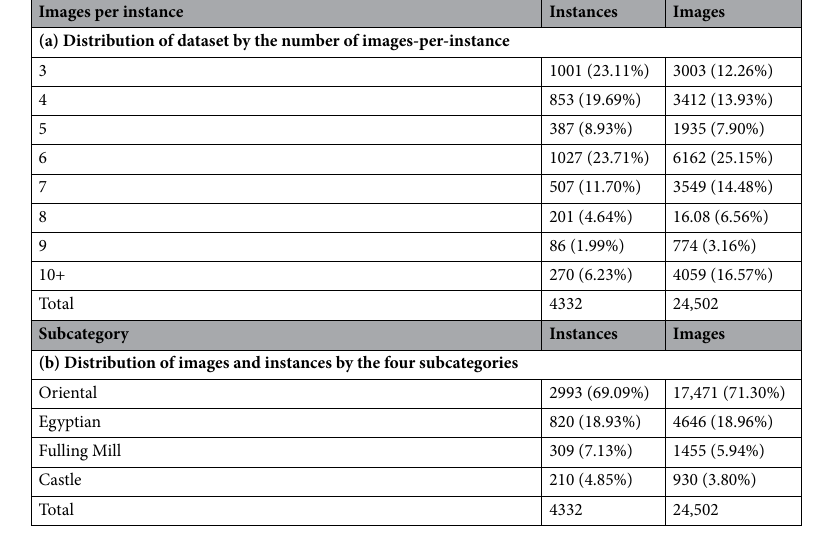
Table 2. Structural breakdown of the dataset used in our experiments.